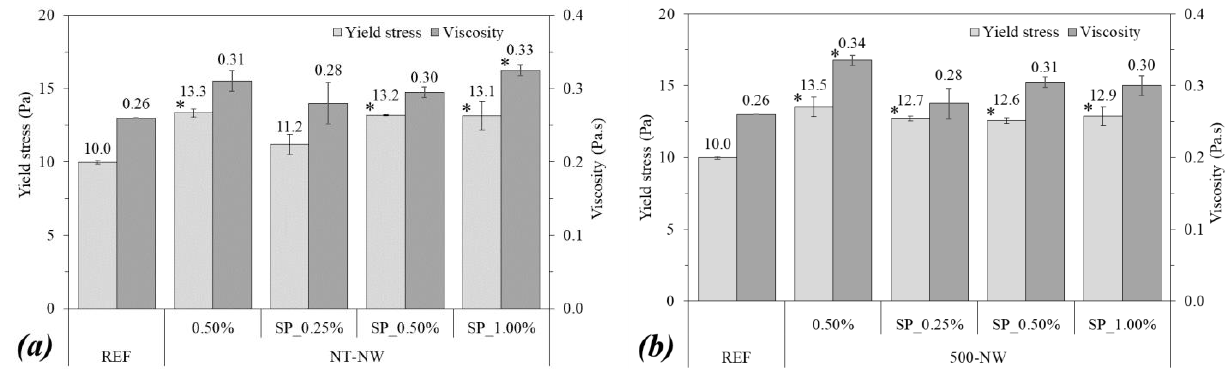
Figure 4. Yield stress (Pa) and plastic viscosity (Pa.s), determined by rheometry, of ( a ) NT-NW and ( b ) 500-NW-based systems. Error bars correspond to ±1 standard deviation. Stars indicate significant differences in comparison with REF and triangles indicate significant differences between the samples with and without SP.